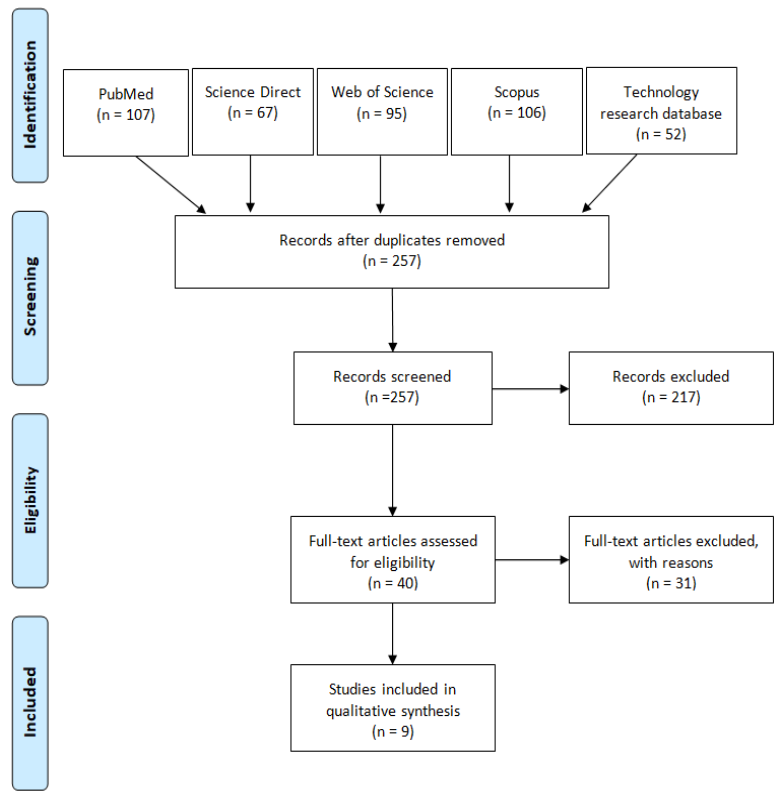
Figure 2. PRISMA flow diagram [12].